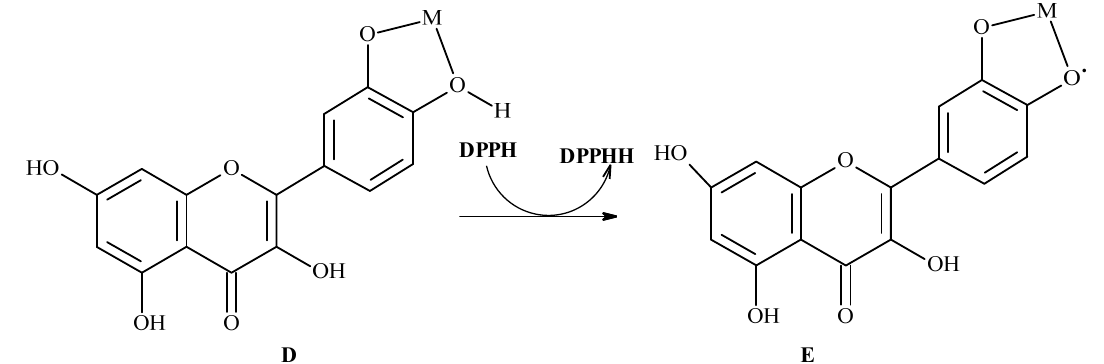
Figure 5. Proposed structures of Zn(II) and Al(III) complexes with quercetin ( A ) M are Al(III) and Zn(II), x = n = 4 for Al(III), x = n = 2 for Zn(II); rutin ( B ) M are Al(III) and Zn(II), x = 4, n = 5 for Al(III), x = n = 2 for Zn(II); galangin ( C ) x = 4 and n = 2 for Al(III), x = 2 and n = 1 for Zn(II).